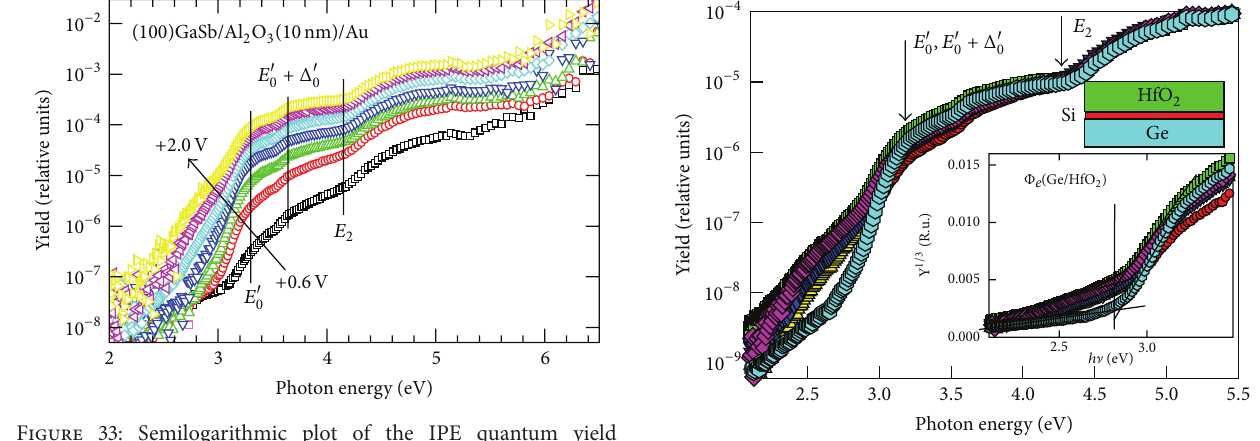
Figure 33: Semilogarithmic plot of the IPE quantum yield as a function of photon energy as measured on (100)GaSb/a- Al 2 O 3 (10nm)/Au sample with the applied bias varying from 0.6V to 2.0 V. The vertical arrows 𝐸 0 , 𝐸 󸀠 0 + Δ 󸀠 0 , and 𝐸 2 mark the energy of direct optical transitions in the GaSb crystal.